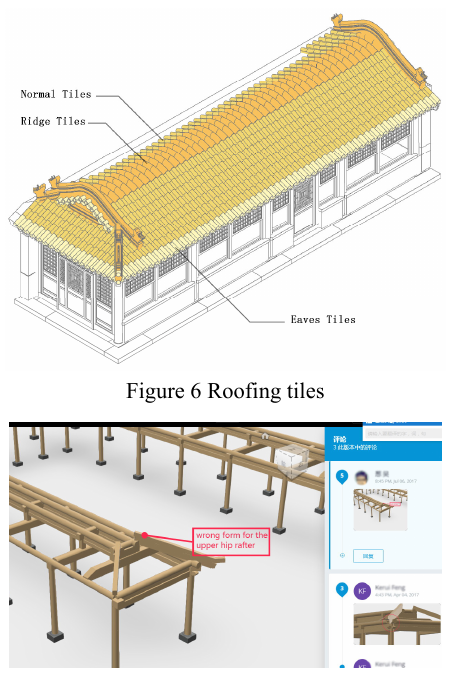
Figure 7 Model proofreading via Autodesk A360